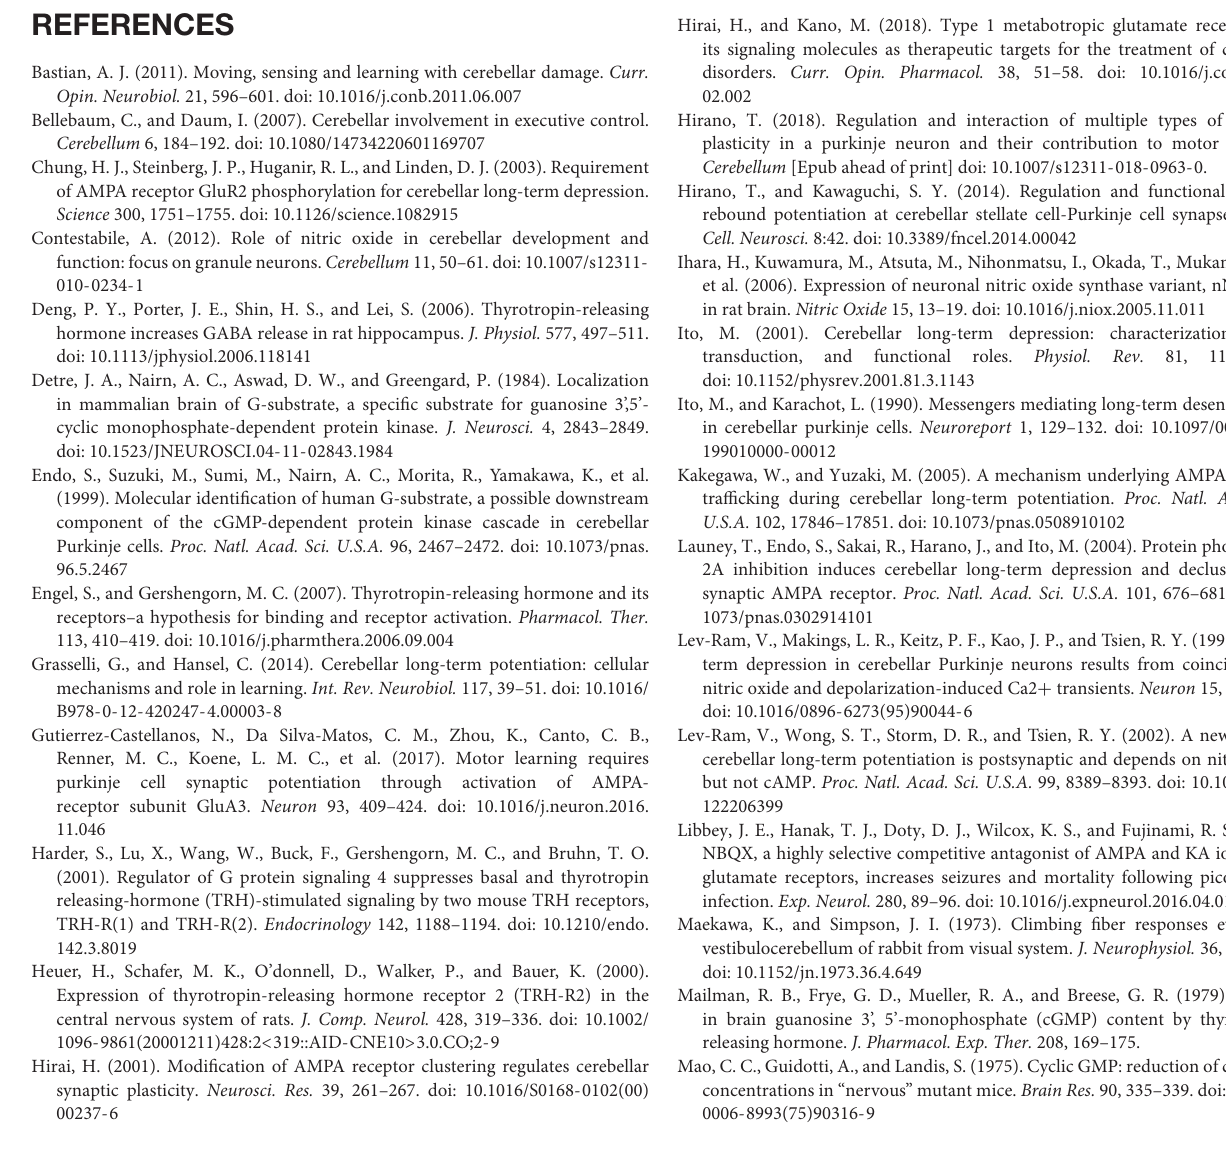
in each group). There are statistically no significant differences among four groups, as determined using repeated-measures analysis of variance. KO, knock-out; WT, wild-type. FIGURE S2 | No significant difference in the amplitude and frequency of both sIPSCs and mIPSCs recorded in PCs between KO mice and their WT littermates. (A) sIPSC traces recorded from WT mouse (left) or KO (right) mouse PCs. (B,C) Graphs showing averaged medial amplitudes (B) and inter event intervals (C) of sIPSCs recorded from TRH-KO mice and their WT littermates (both genotypes, n = 9 PCs from three mice). (D) mIPSC traces recorded from WT mouse (left) or KO (right) mouse PCs in the absence (upper) and presence (lower) of picrotoxin (100 µ M). (E,F) Graphs showing averaged medial amplitudes (E) and inter event intervals (F) of mIPSCs recorded from TRH-KO mice and their WT littermates (both genotypes, n = 7 PCs from three mice). No statistically significant difference was detected using the Welch’s t -test. Scale bar: 50 pA and 1 s for (A,D) . KO, knock-out; mIPSCs, miniature inhibitory postsynaptic currents; N.S., not significant; PTX, picrotoxin; sIPSCs, spontaneous inhibitory postsynaptic currents; WT,